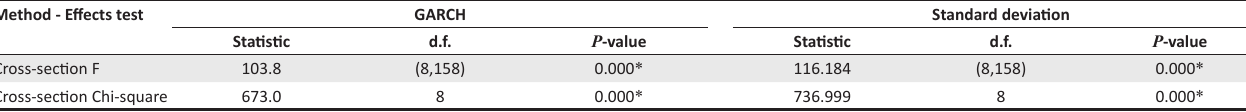
TABLE 9: Redundant fixed effects tests.